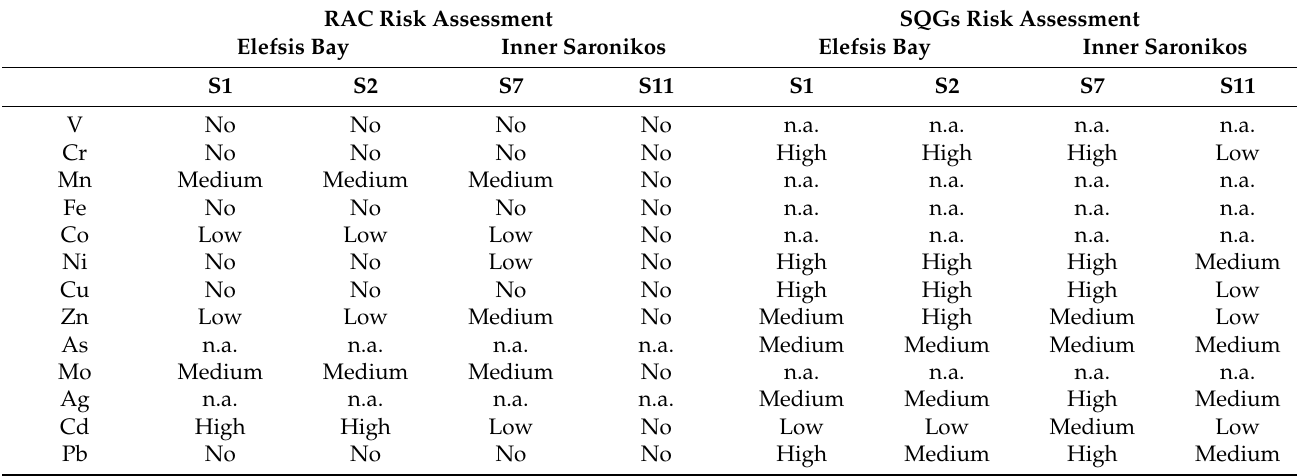
Table 5. Metal toxicity risk assessment of the Elefsis Bay and Inner Saronikos Gulf sediments based on the RAC and